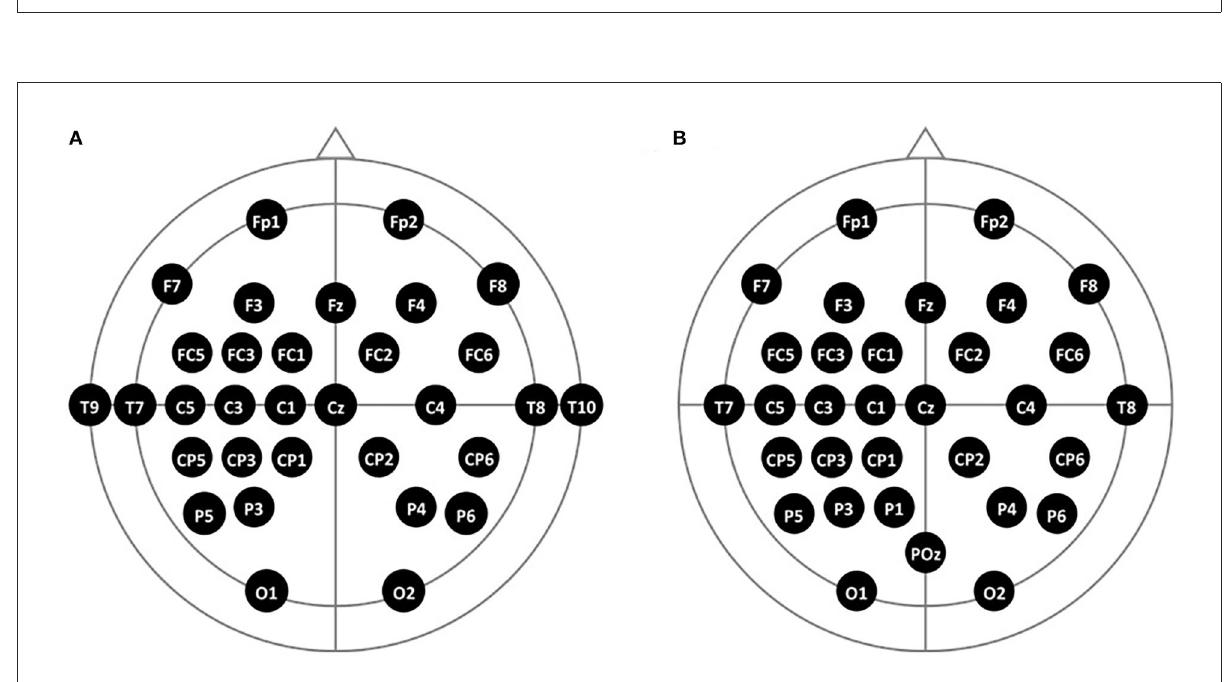
FIGURE4 The 10–20 system-based 32-channel locations of two participant groups. (A) Locations of the healthy group and (B) locations of the stroke group.